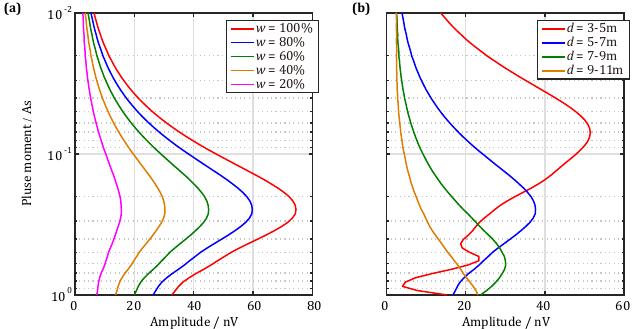
Figure 2. Sounding curves of forward-calculated UMRS signal versus the pulse moment received by the meter-scale antenna for a a 2-m-thick water-bearing layer. ( a ) The center location is 6 m in front and the water content is reduced from 100% to 20%; ( b ) the water content remains 50% and the center location varies from 4 m–10